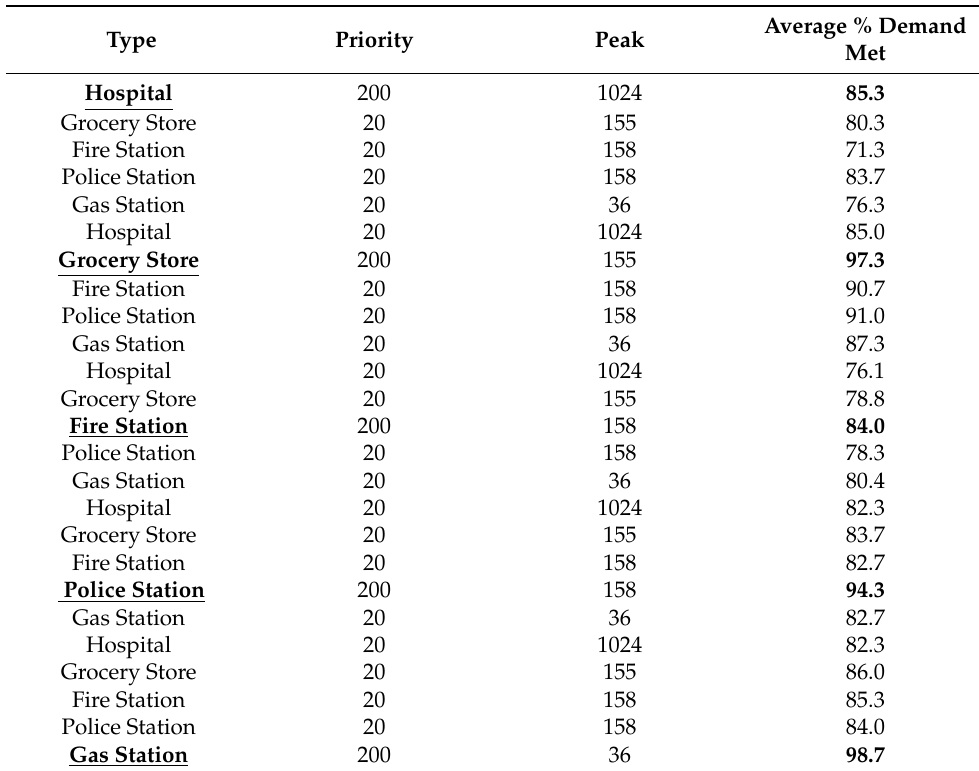
Table 5. Sensitivity to prioritization of one node type above all others. The results in bold indicate the effectiveness of prioritization with higher percentage of average demand